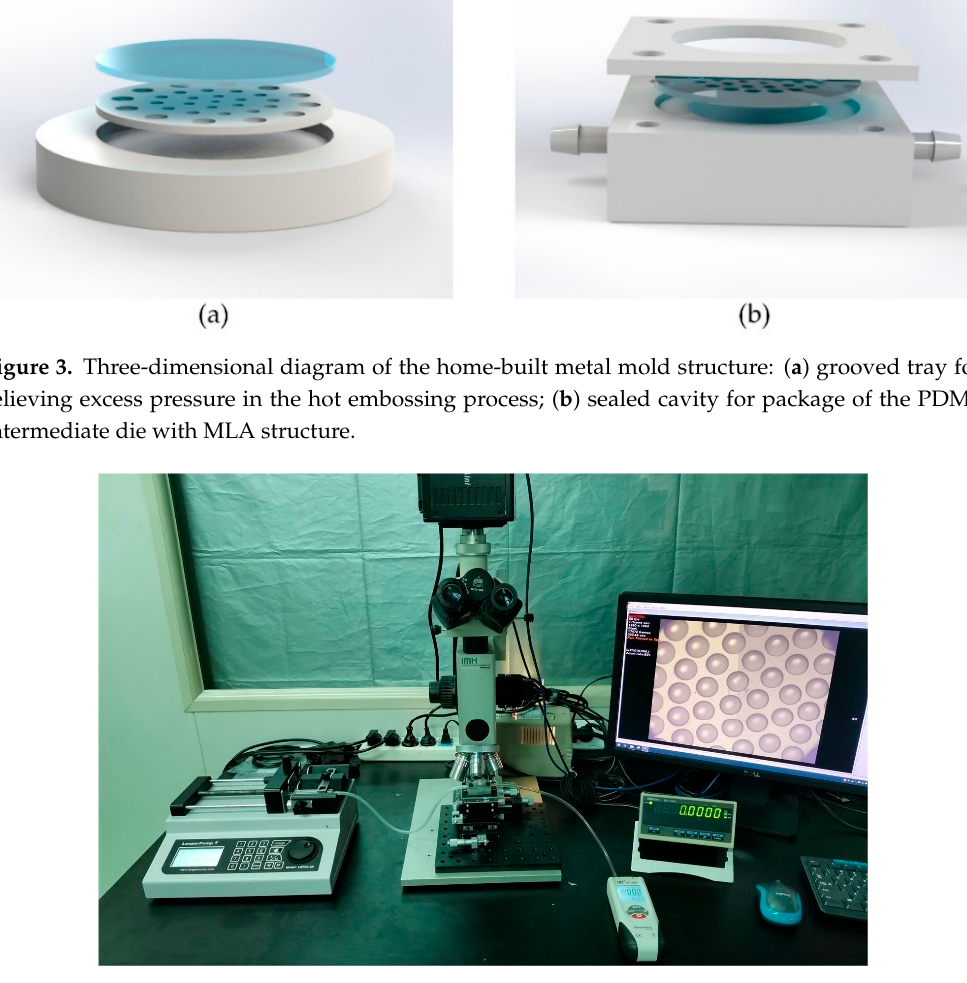
Figure 4. Experimental setup used to measure altitudes of MLAs with different diameters and sag height of PMDS deformation under different pressure in real time.